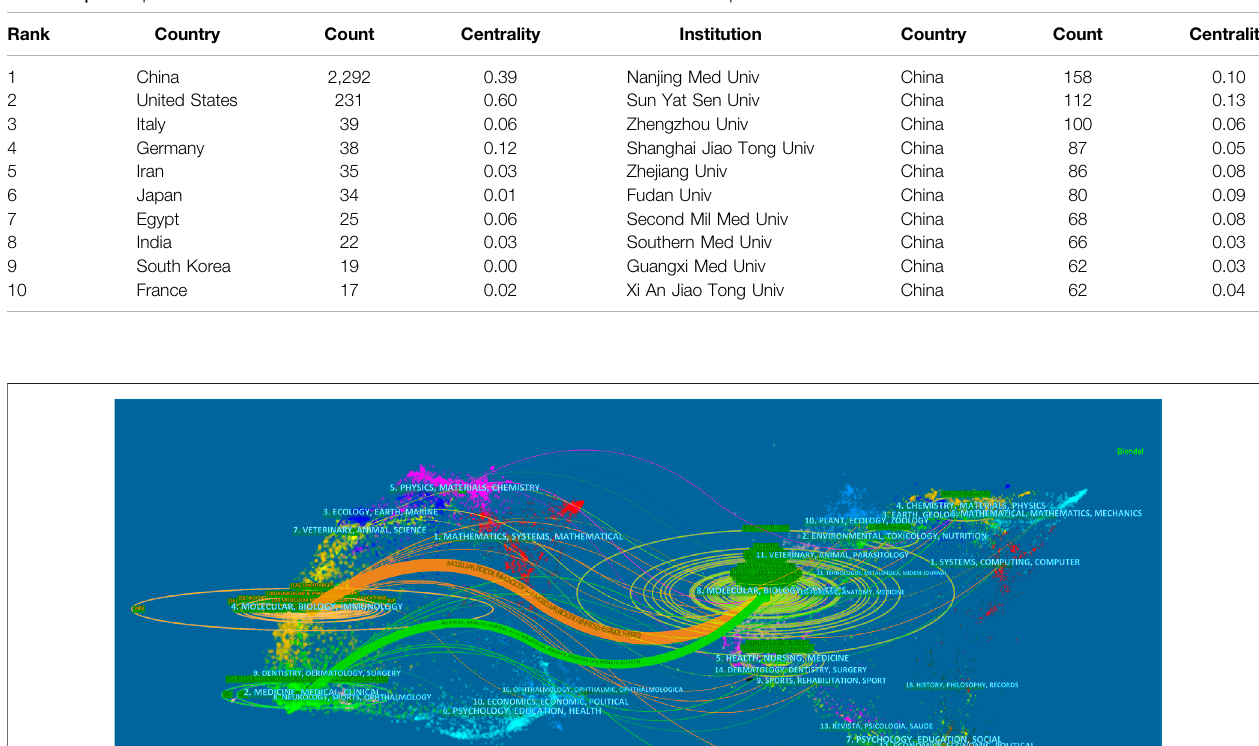
Table 1 ; the results indicated that China was the fi rst leading country regarding the amount of publications (2,292), followed by the United States (231), Italy (39), and Germany (38). Among all the countries, China and the United States played a leading role in collaborative networks.